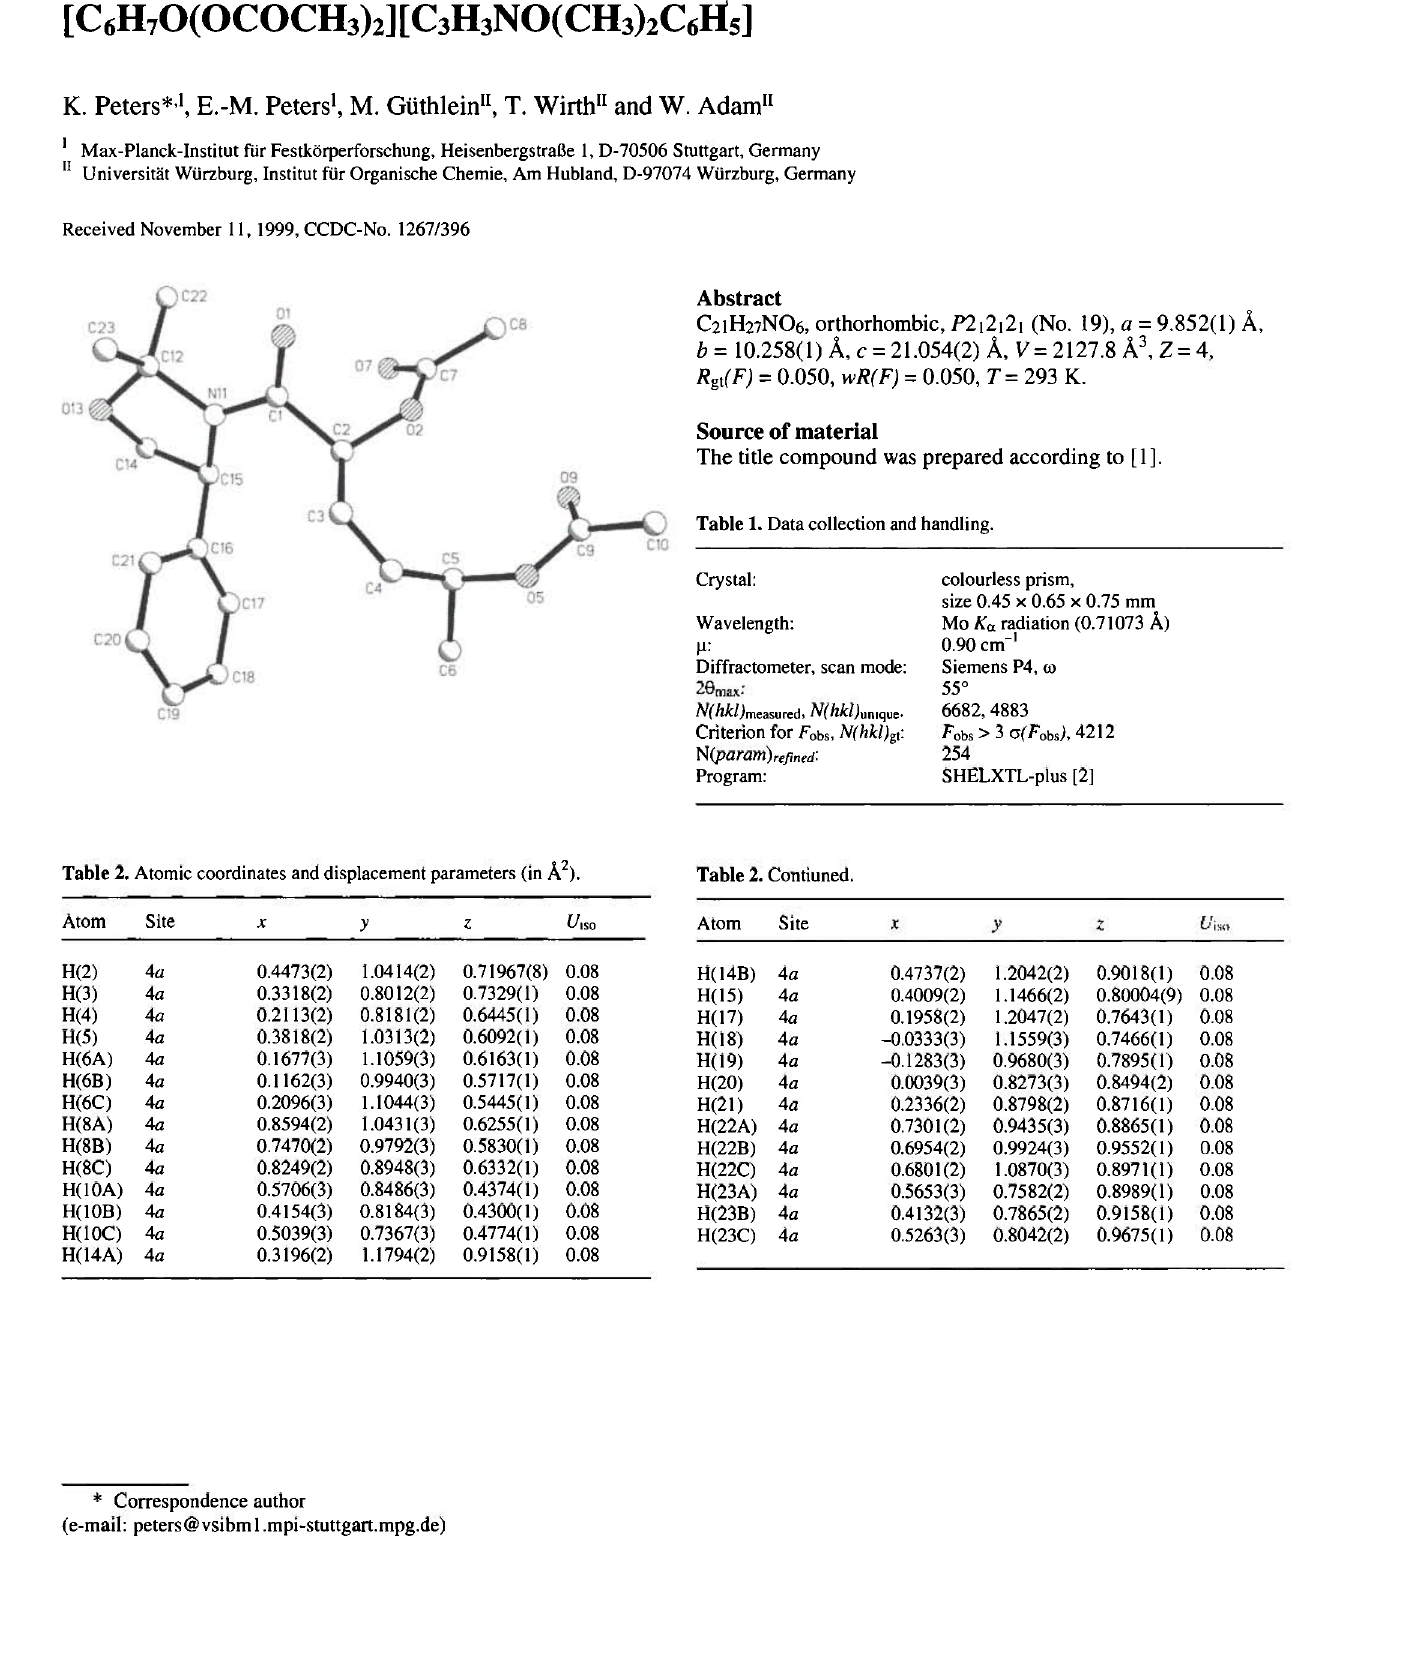
Table 1. Data collection and handling.